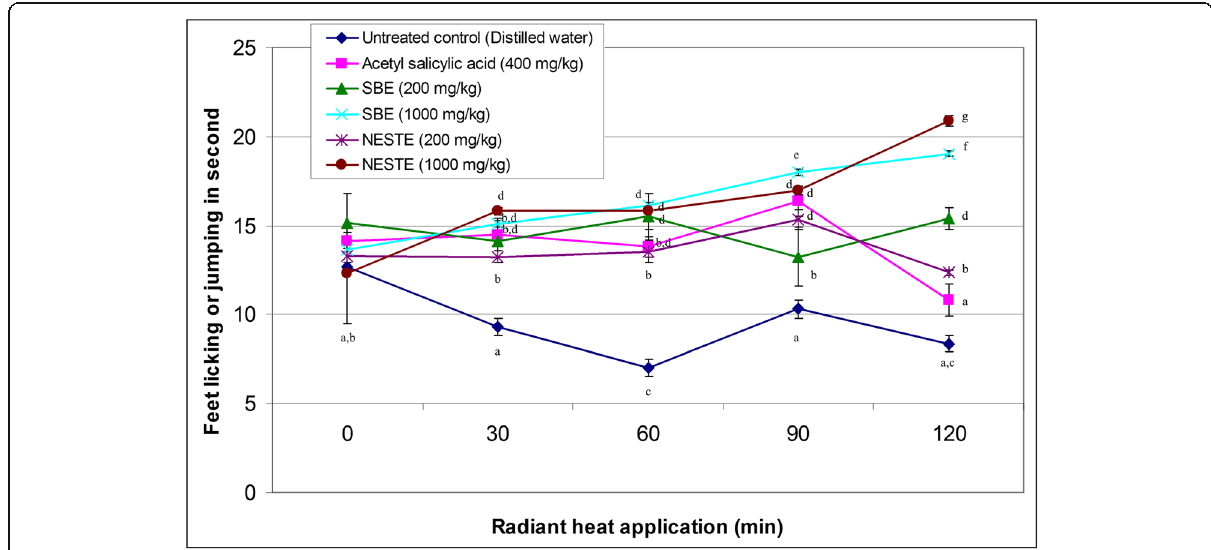
Fig. 3 Analgesic activity of NESTE and SBE by hot plate method on mice. Note: The data represents as mean of licking/jumping for every 40 s ± S.E.M from six mice, Acetyl salicylic acid was used as reference